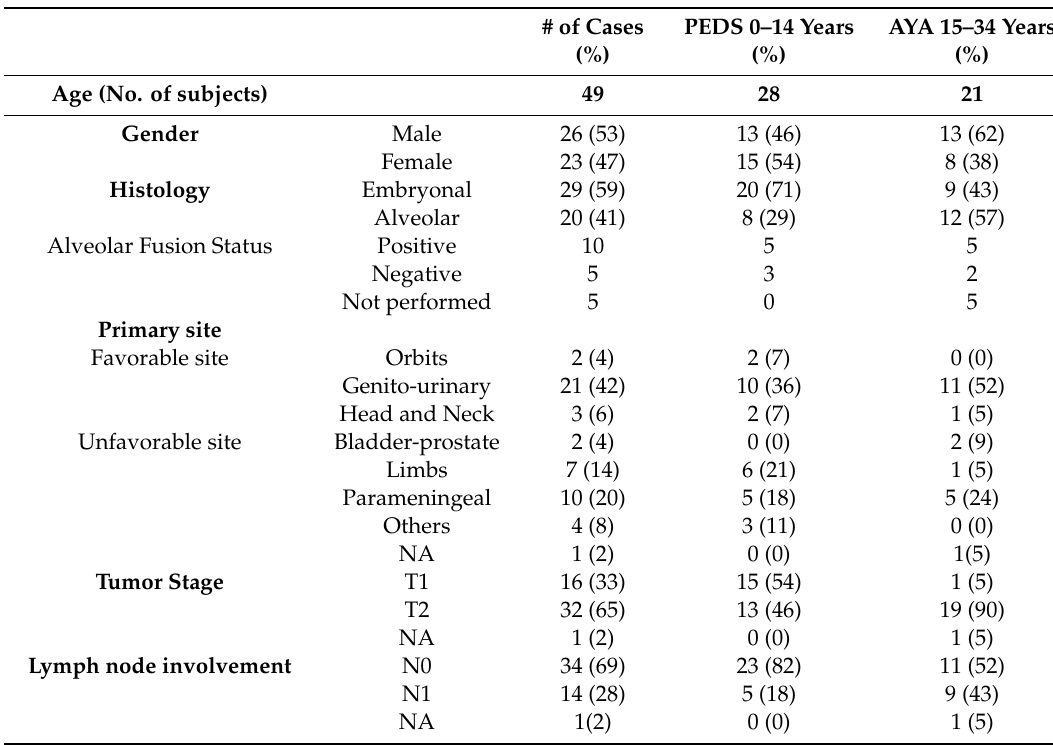
Table 1. Clinical pathological features of the RMS